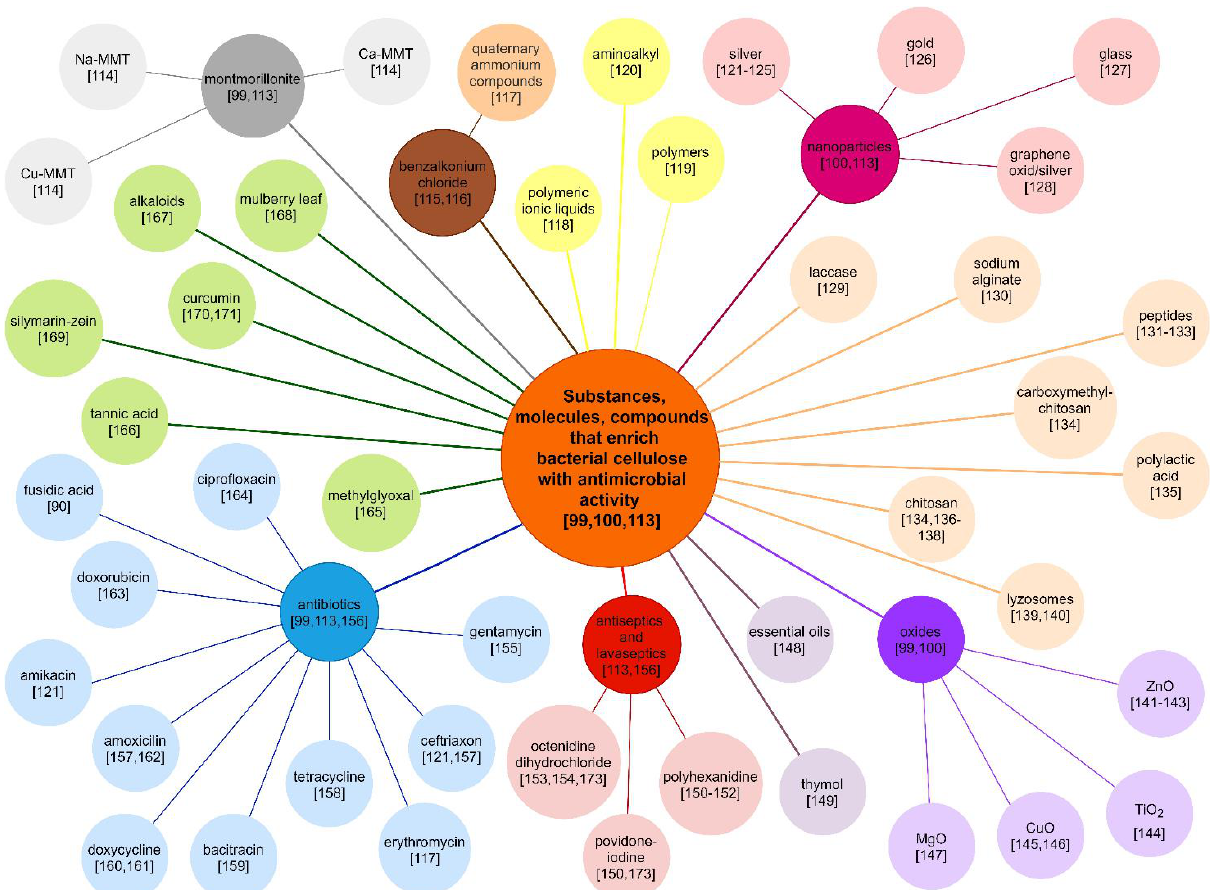
Figure 3. Examples of compounds/substances/molecules introduced to bacterial cellulose (BC) as an antimicrobial additive. MgO — magnesium oxide; CuO — copper oxide; TiO 2 — titanium dioxide; ZnO — zinc oxide; Na-MMT — sodium montmorillonite; Ca-MMT — calcium montmorillonite; Cu-MMT — copper montmorillonite [92,99,100,113 – 173].